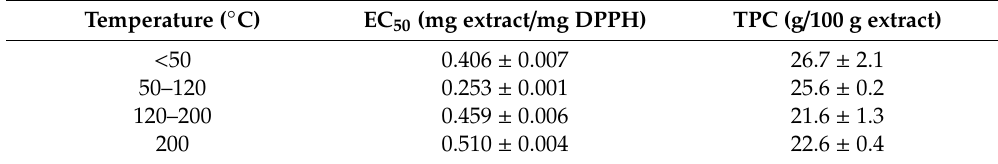
Table 5. Phenolic compounds in the SBW extracts obtained in the assay targeting 200 ◦